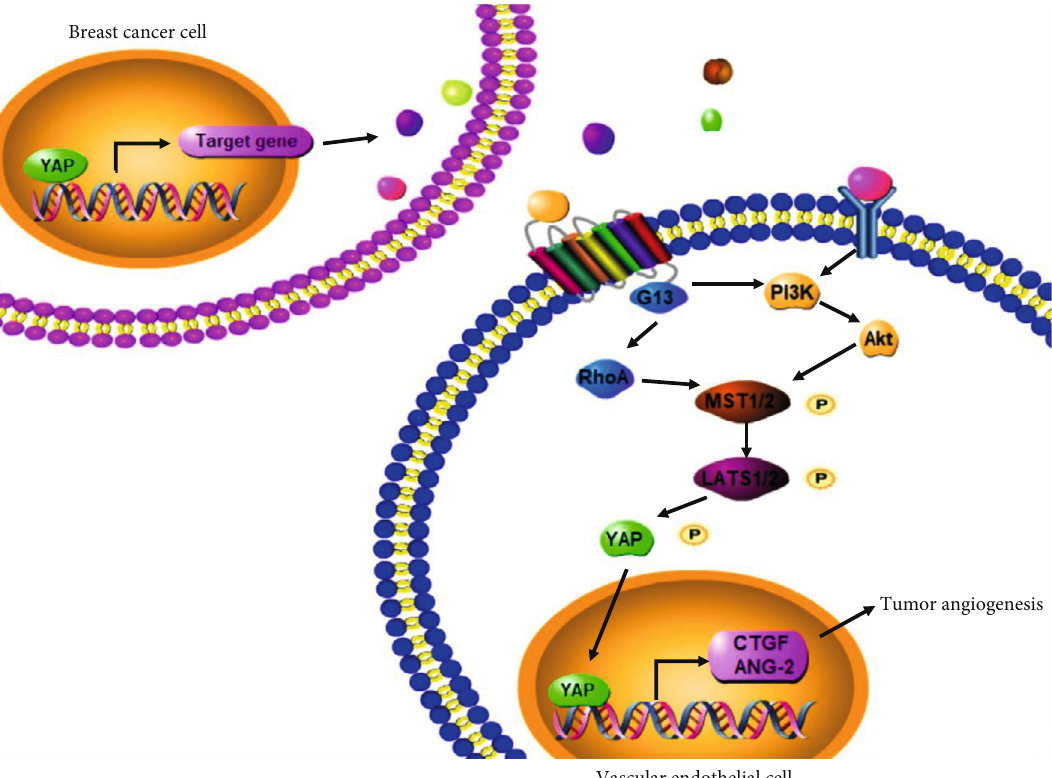
Figure 7: The concept map depicted the role of YAP-YAP interaction in breast cancers and vascular endothelial